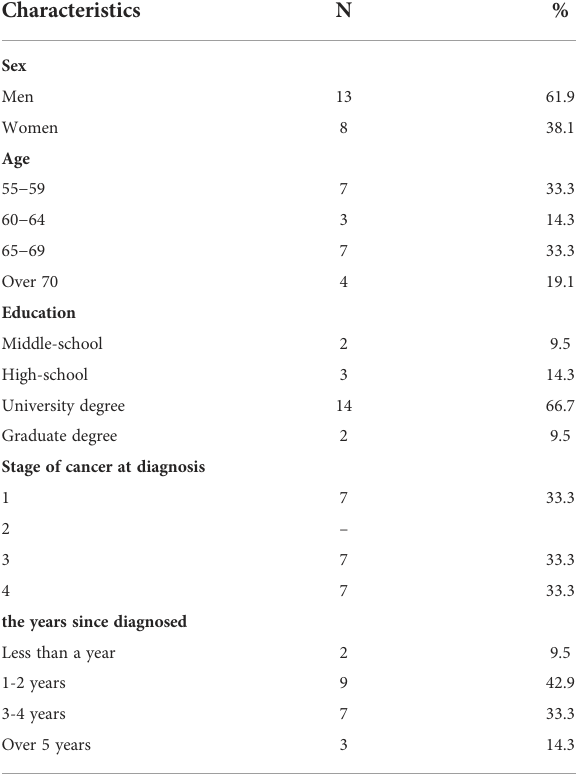
TABLE 1 Study participants ’ general characteristics.